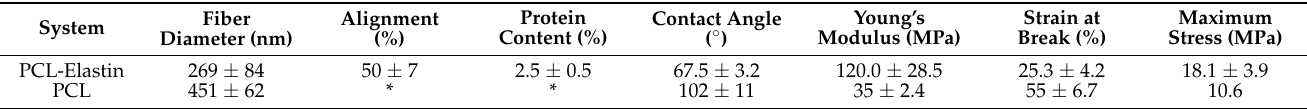
Table 1. Mean fiber diameter, alignment, protein content, contact angle, Young’s modulus, strain at break and maximum stress values of PCL/elastin scaffolds. Some of the parameters obtained for PCL scaffolds were also included as reference. * means that there is no data reported